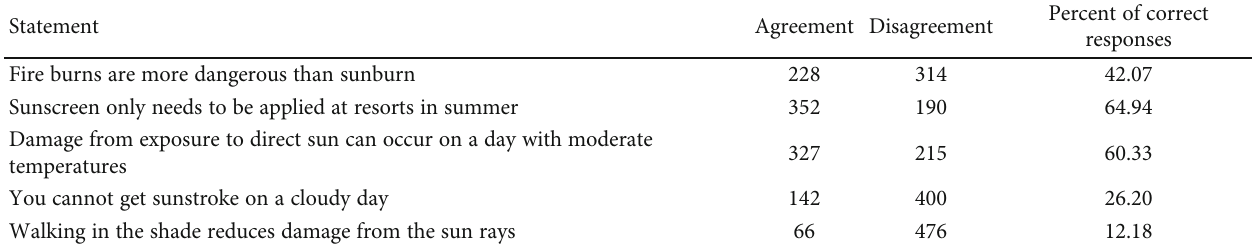
Table 1: Analyses of the percentage of correct answers to the fi ve statements in KAU during the study.